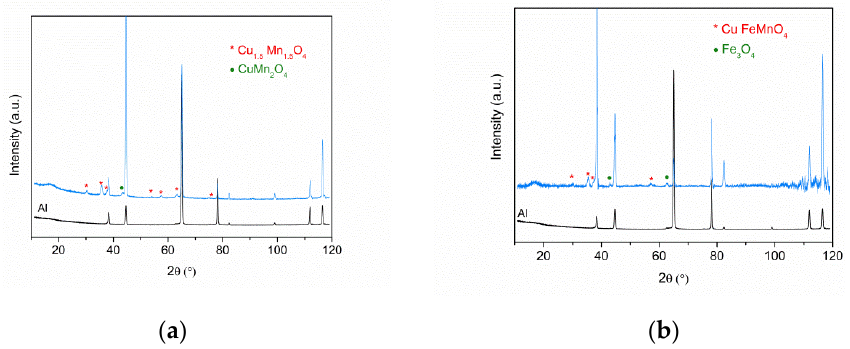
Figure 1. ( a ) XRD spectra of etched aluminium substrate and the CuMnO x film sintered at 600 °C; ( b ) XRD spectra of etched aluminium substrate and the CuFeMnO x coating sintered at 600 °C.